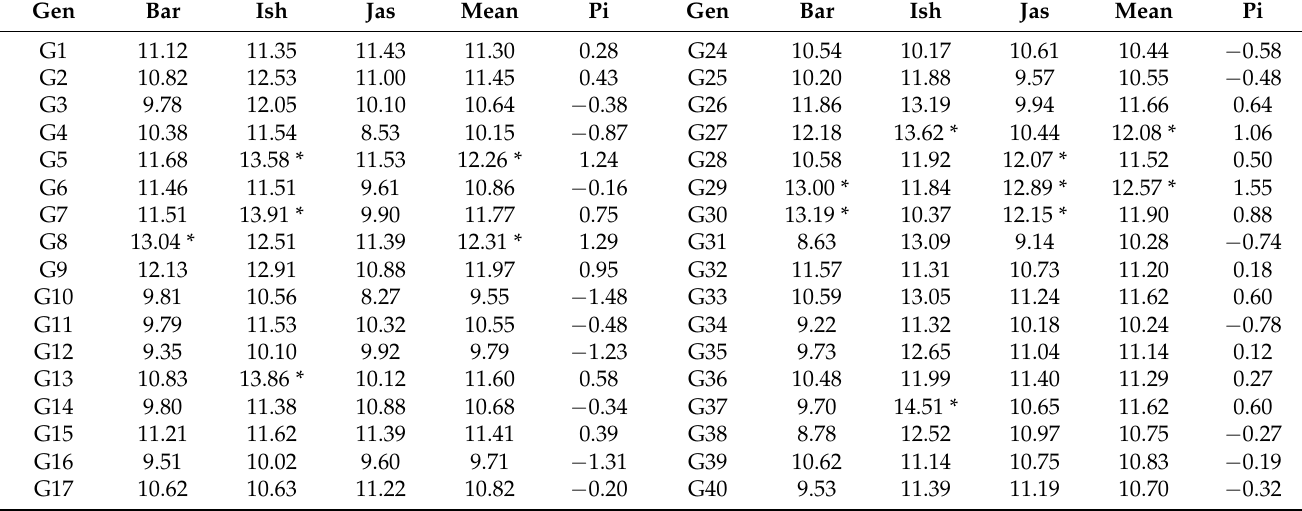
Table 8. Mean grain yield performances of the studied genotypes at different